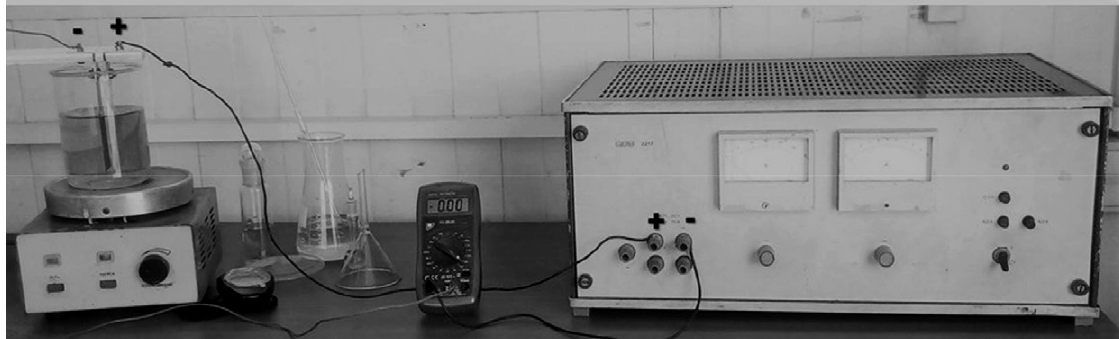
Figure 1. Experimental installation of